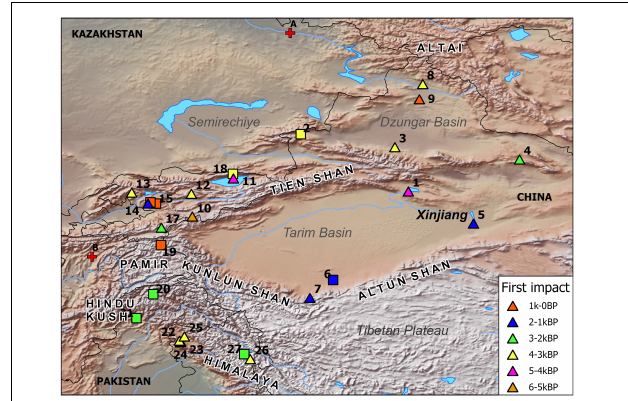
FIGURE 2 | Locations of proxy records examined here and timing of first anthropogenic impacts. Numbers refer to records in Table 1 . Triangles indicate multi-proxy and squares indicate single-proxy records. Red crosses indicate additional climate records, as described in Figure 3 : (A) Ozerki Swamp (Tarasov et al., 1997) and (B) CSM loess section (Gao et al.,